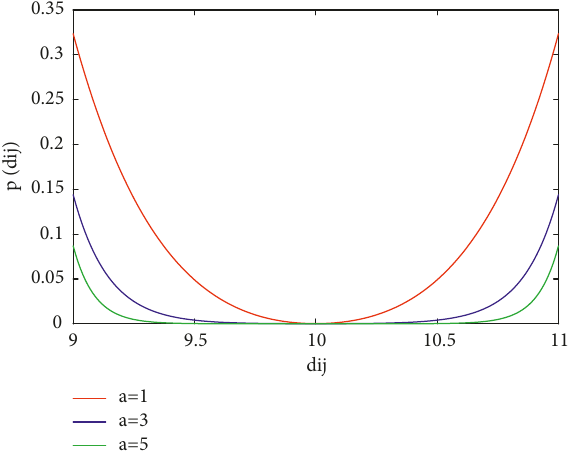
Figure 2: The plot of the artificial potential function P ( d respect to actual distance. The parameter a affects the range size of low potential